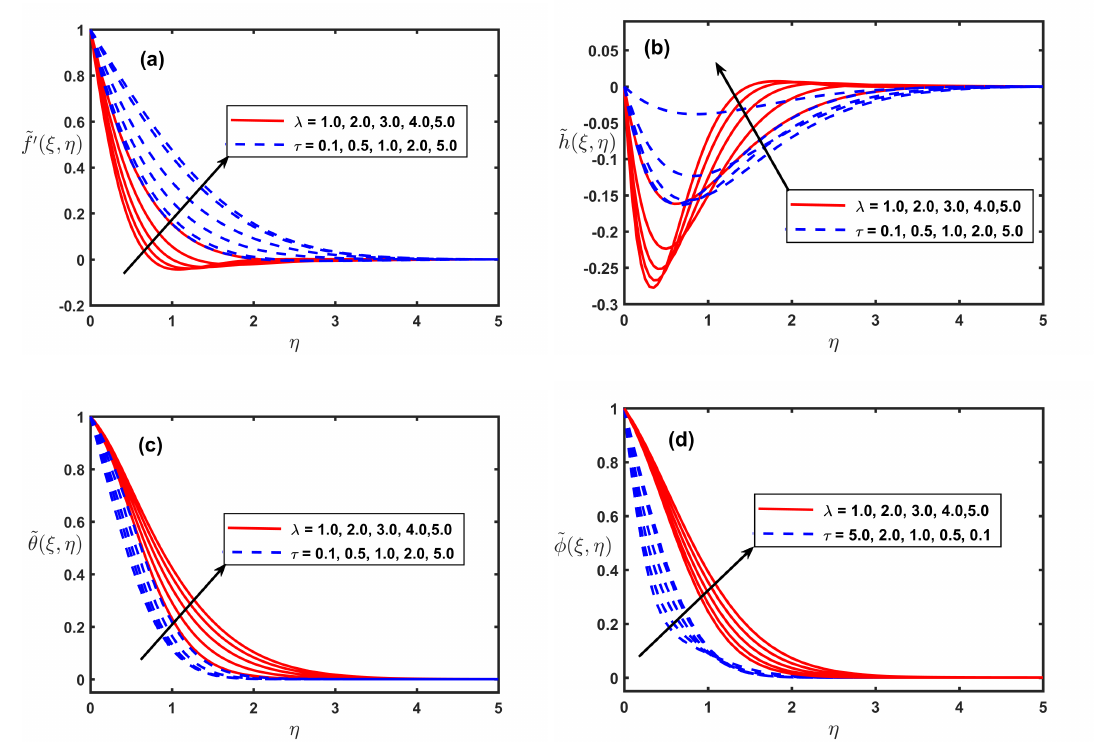
Figure 5. Fluctuation of ˜ f (cid:48) ( ξ , η ) , ˜ h ( ξ , η ) , ˜ θ ( ξ , η ) , and ˜ φ ( ξ , η ) along with λ and τ .